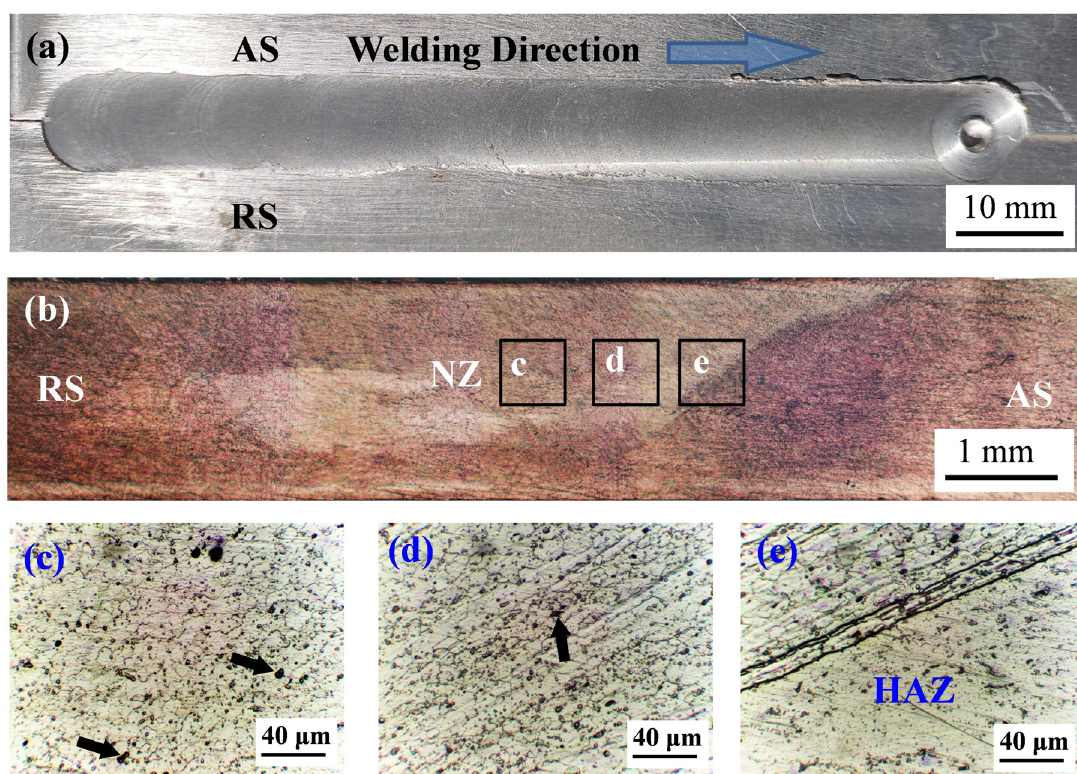
Figure 5. Microstructure of welding joint (a) Weld appearance, (b) Macro metallographic diagram of weld cross section (c) Center of NZ (d) NZ adjacent to AS (e) Junction of NZ and HAZ (The black arrows in Figure5(c) and (d) indicate the corrosion